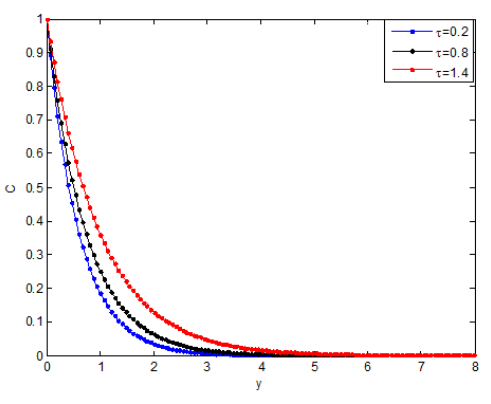
Figure 24. Effects of flow time on the concentration distribution